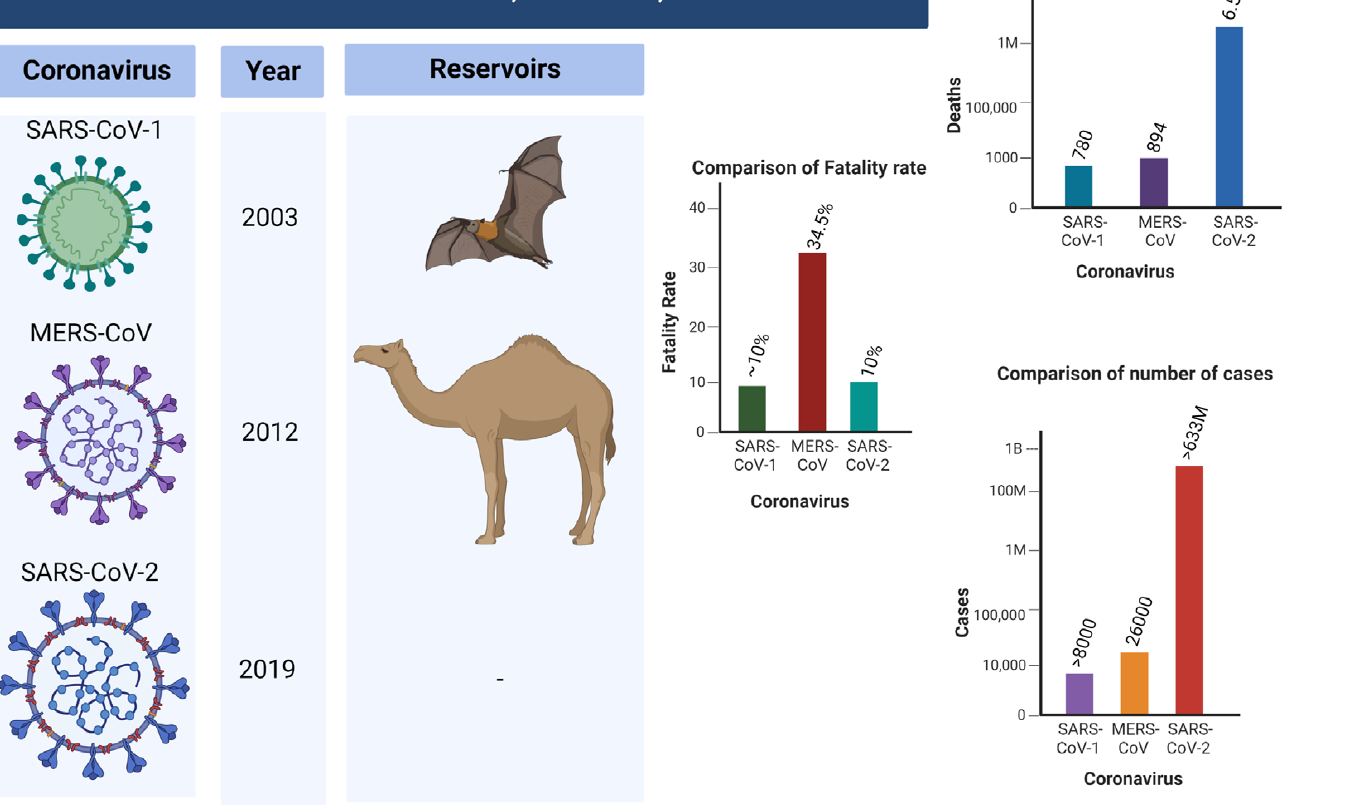
Figure 1. Comparison between SARS-CoV-1, MERS-CoV-2, and SARS-CoV-2.